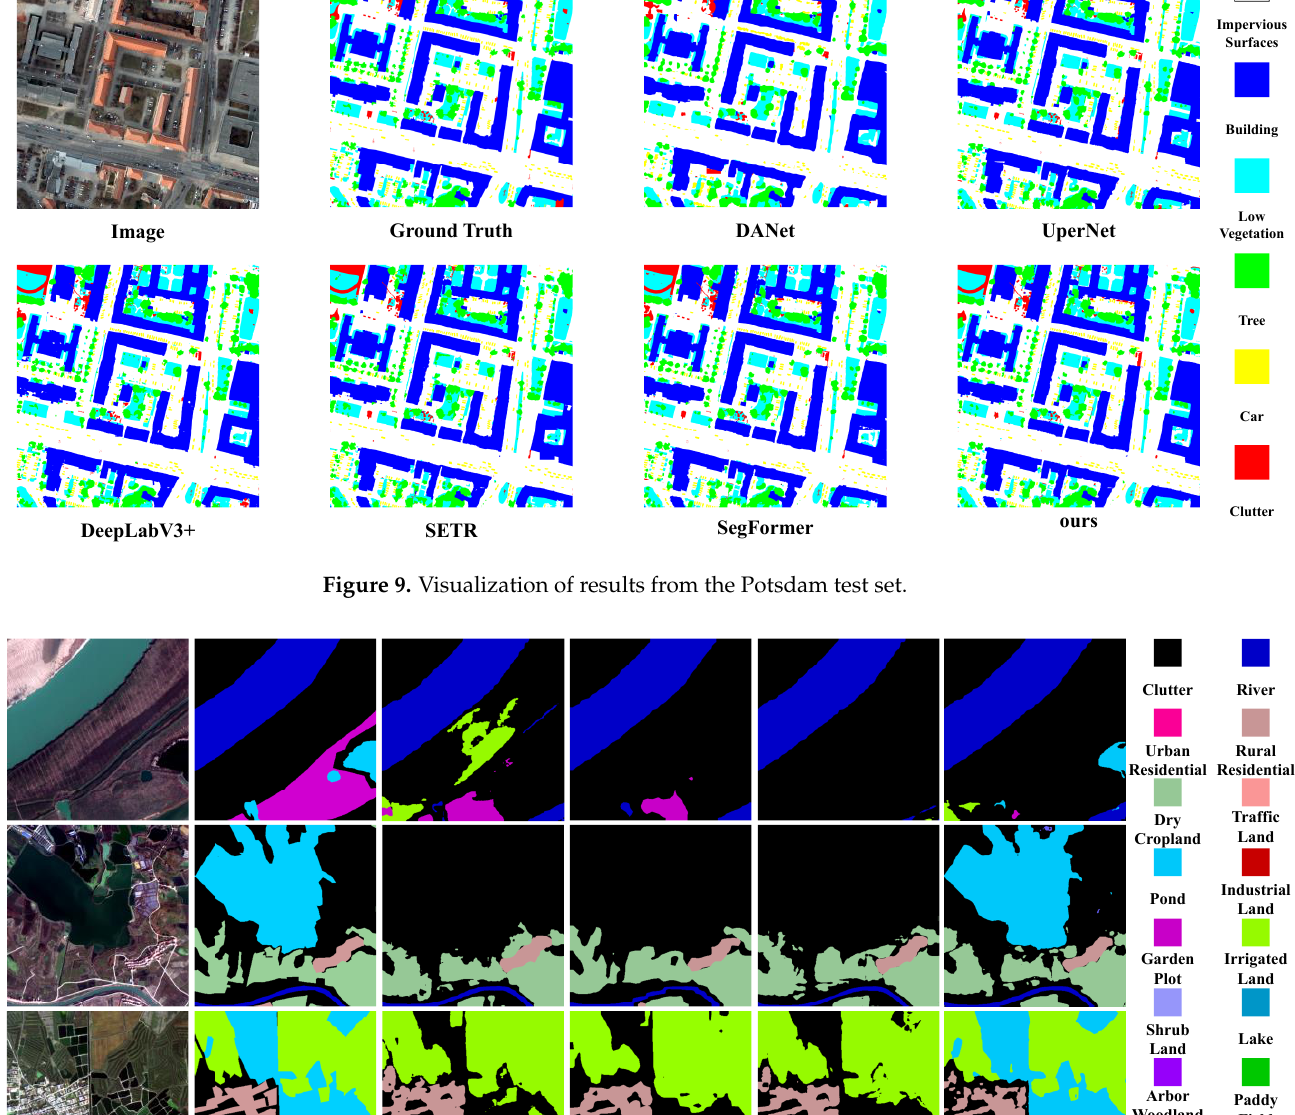
Table 9. Comparison with the state-of-the-art networks on the Potsdam dataset.